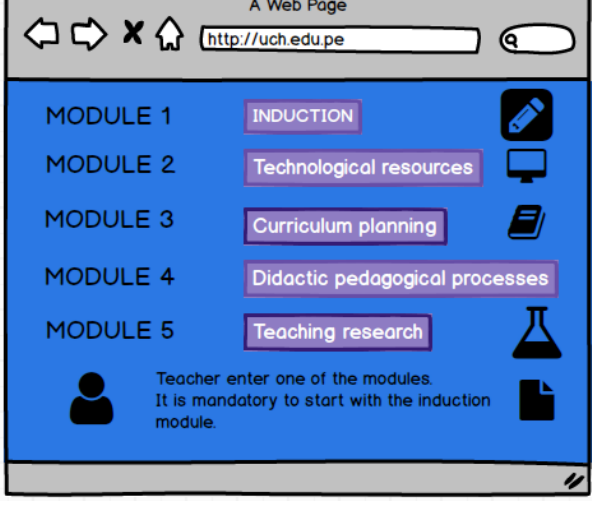
Fig. 9. Modules that can be chosen by teachers